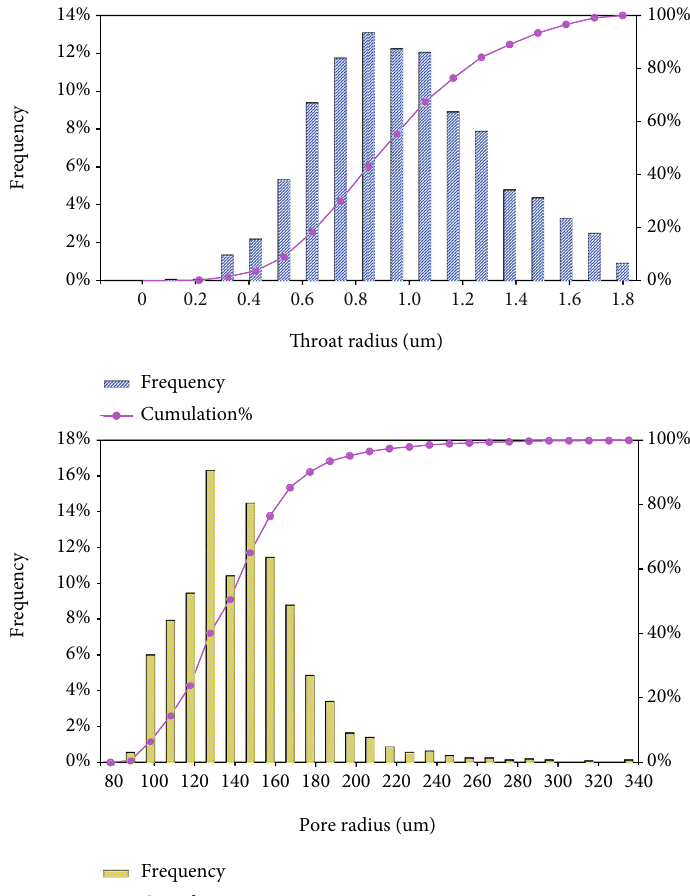
Figure 6: Distribution feature of throats and pores in reservoirs of Yn5-2 samples.